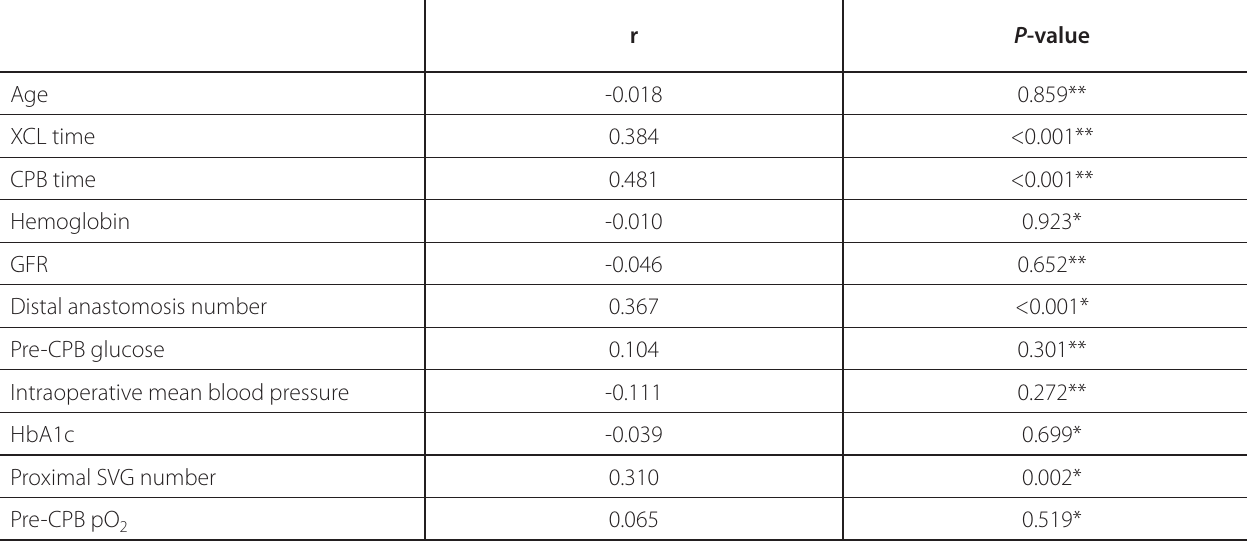
Table 4 . Correlation of several operative and patient characteristics with the postoperative lactate